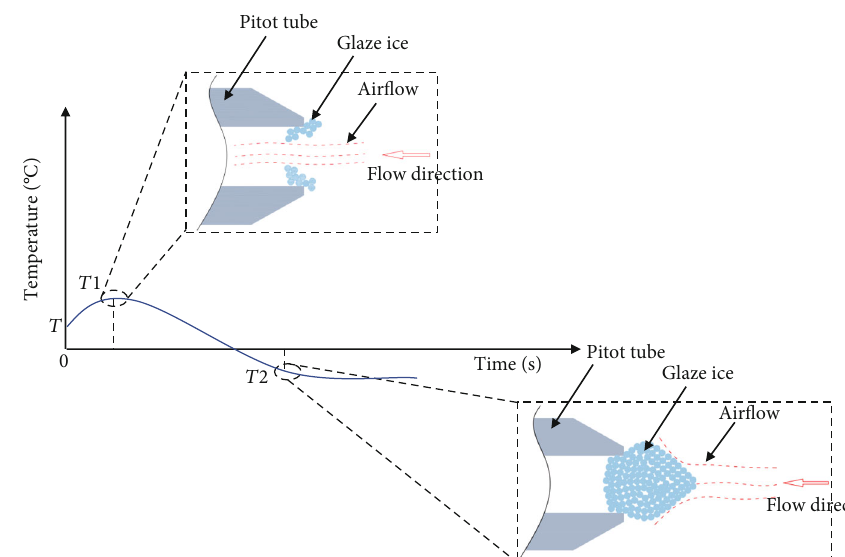
Figure 13: Temperature change of the pitot tube blocked by glaze ice. At the beginning of the experiment, the initial temperature of the pitot tube is assumed to be T . After the water droplets solidi fi ed for a period, the pitot tube temperature reaches T 1 . At this time, the pitot tube is partially blocked, and the temperature of the pitot tube drops. At T 2 , the pitot tube is completely